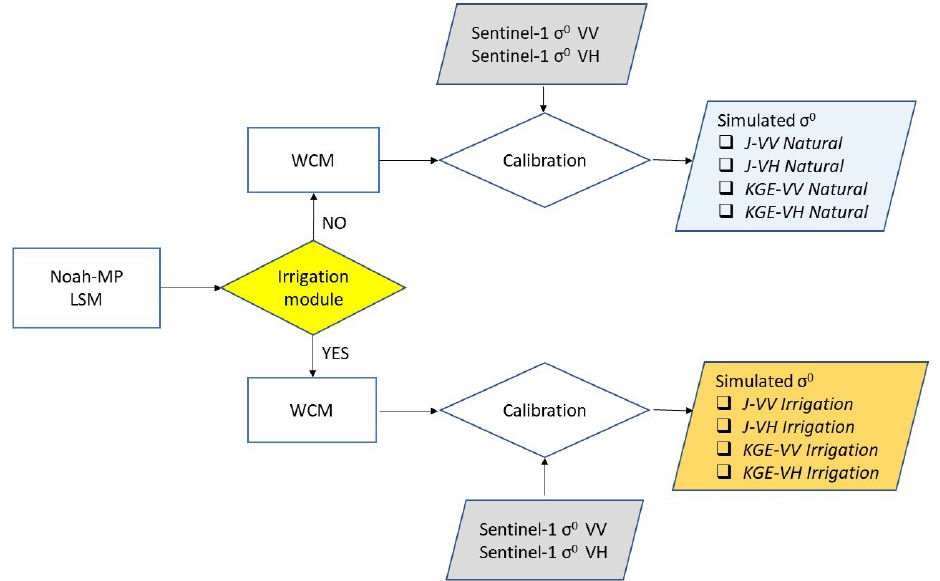
Figure 3. Flow chart of the experimental set-up used in this study to calibrate the WCM σ 0 signal. A natural and an irrigation experimental line was performed coupling either Noah-MP natural or irrigation simulations with the WCM. For each experimental line, σ 0 simulations are driven by the Sentinel-1 signal using two different cost functions ( J and KGE) in order to provide eight different calibration